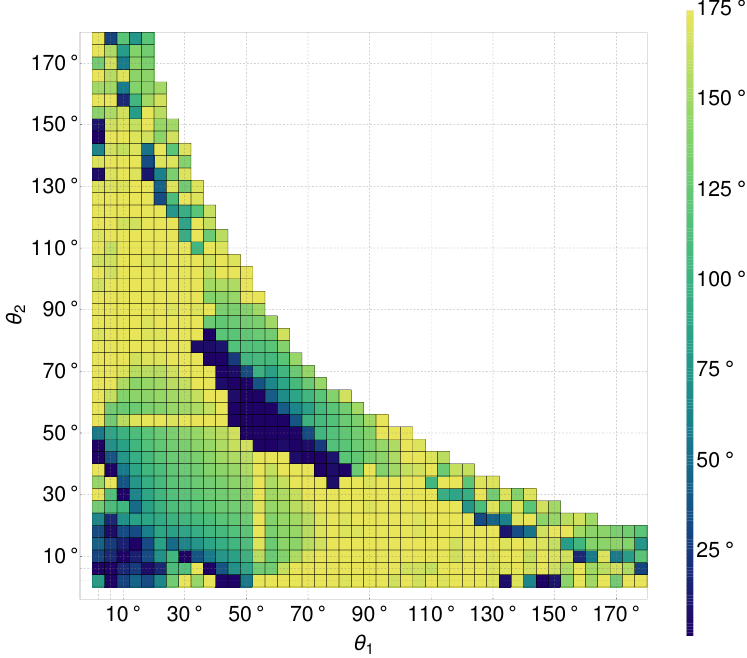
Figure 2: The distribution of the relative azimuthal angle ϕ responding to the maximal ∆ SIGS in the cross section distribution (see Fig. 1) for the deuteron breakup process at E = 13 MeV.